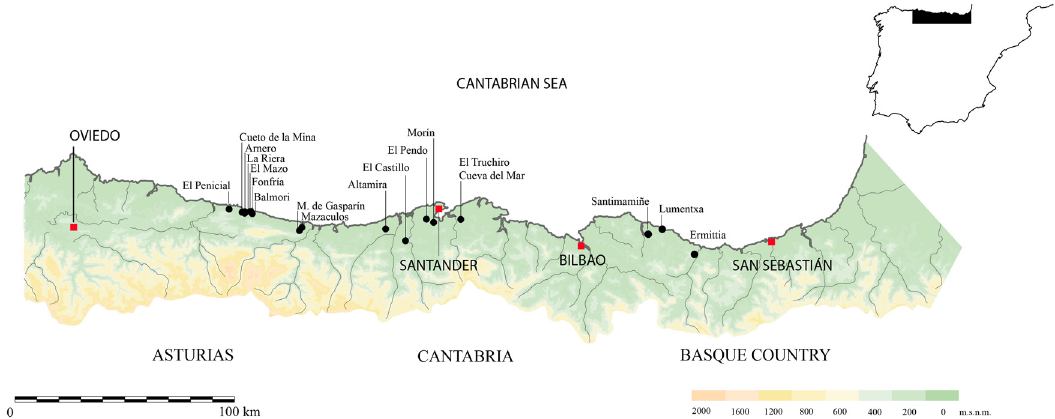
Figure 1: Map of northern Iberia with the location of the archaeological sites and municipalities mentioned in the